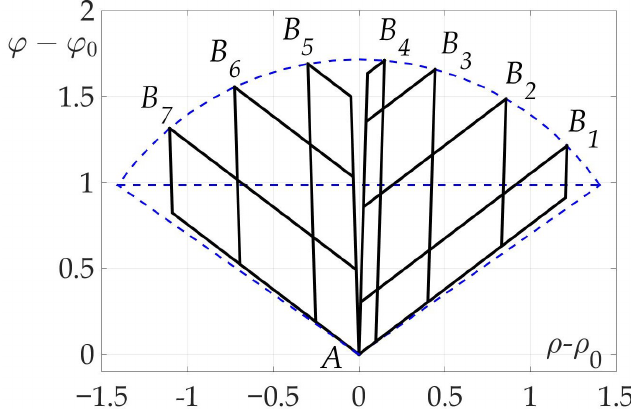
Figure 19. Some optimal two-link paths with different β 0